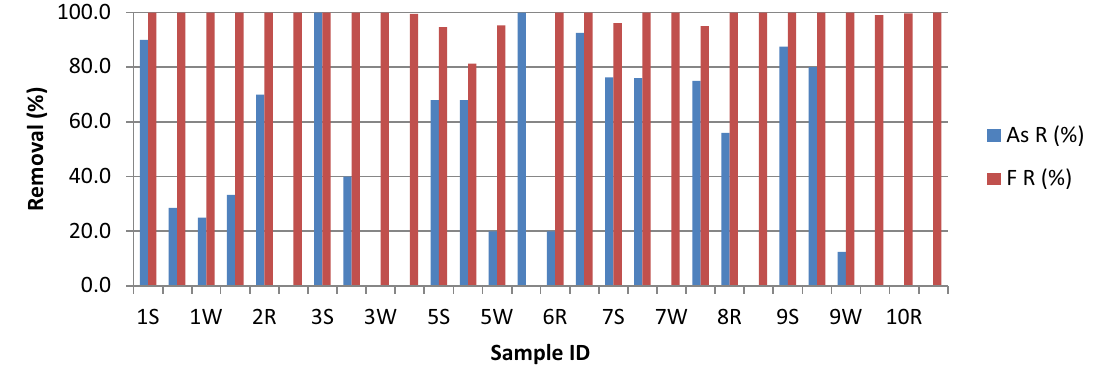
Fig. 10 Removal percentage of Fluoride and Arsenic after treatment of real water samples with